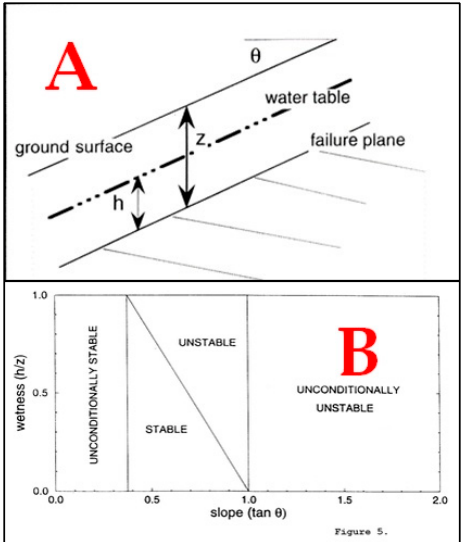
Figure 7. ( A ) The one-dimensional approximation used in the SHALSTAB slope stability model in which the failure plane, water table, and ground surface are assumed parallel. The slope is θ , the height of the water table is h, and the thickness of the colluvium that slides above the failure plane is z. Typically, the failure plane is at the colluvium-weathered bedrock or saprolite boundary. ( B ) Definition of stability fields. For this example, the angle of internal friction is 45 degrees, and the bulk density ratio is 1.6